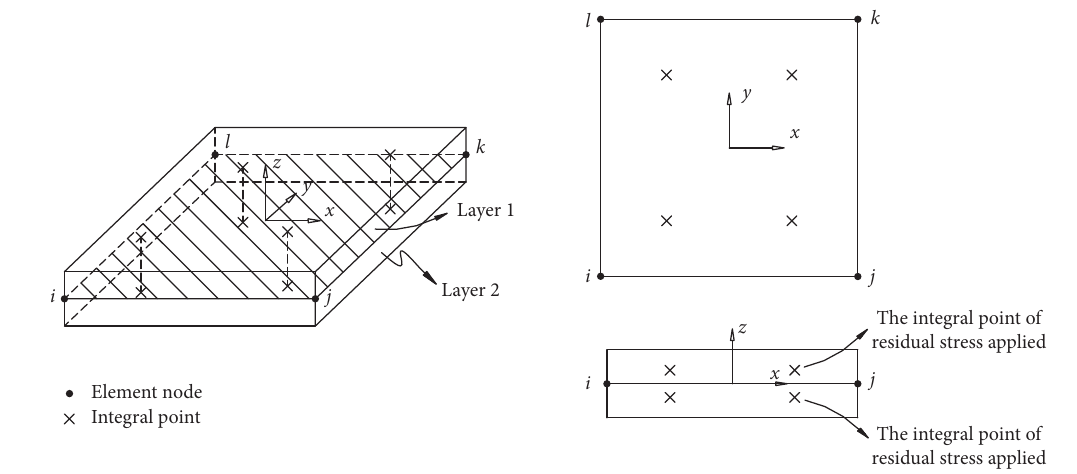
Figure 6: Integral point arrangement. Table 3: Comparison of FEA results and experimental